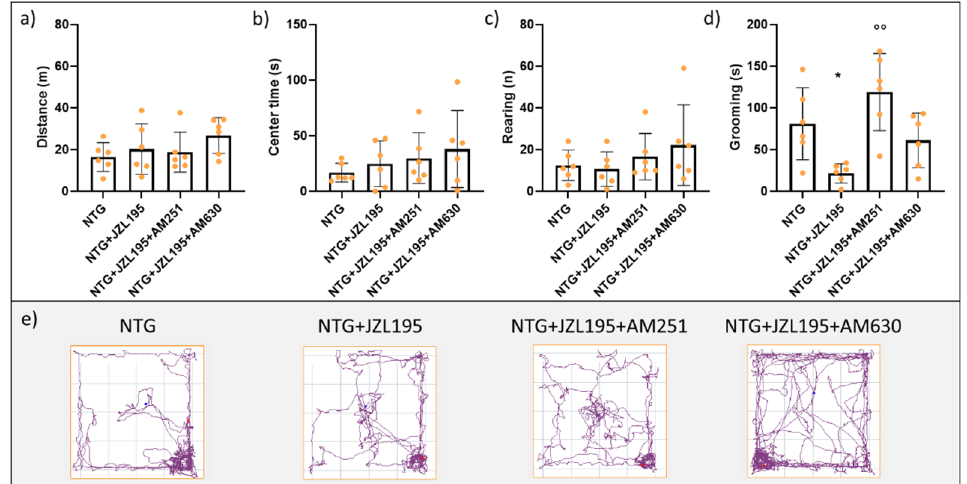
Figure 3. Open field test analysis. ( a ) Distance (expressed in meters) travelled in the apparatus; ( b ) time spent (expressed in seconds) in the center of the apparatus; ( c ) number of rearing; ( d ) time spent in grooming behavior (expressed in seconds); ( e ) representative track plots of the different experimental groups. Male Sprague–Dawley rats were treated with JZL195 (3 mg/kg) with or without the CBs antagonist (1 mg/kg) dissolved in a volume of 2 mL/kg of vehicle (Tween-80/polyethylene glycol 200/saline) 2 h after NTG injection. The locomotor activity, anxiety, and different types of behaviors were evaluated 4 h after NTG injection. Data are expressed as mean ± SD. One-way ANOVA followed by Tukey’s multiple comparisons test; * p < 0.05 vs. NTG; °° p < 0.01 vs. NTG + JZL195. NTG: nitroglycerin group ( n = 6); NTG + JZL195: nitroglycerin + JZL195 group ( n = 6); NTG + JZL195 + AM251: nitroglycerin + JZL195 + CB1 antagonist group ( n = 6); NTG + JZL195 + AM630: nitroglycerin + JZL195 + CB2 antagonist group ( n = 6).